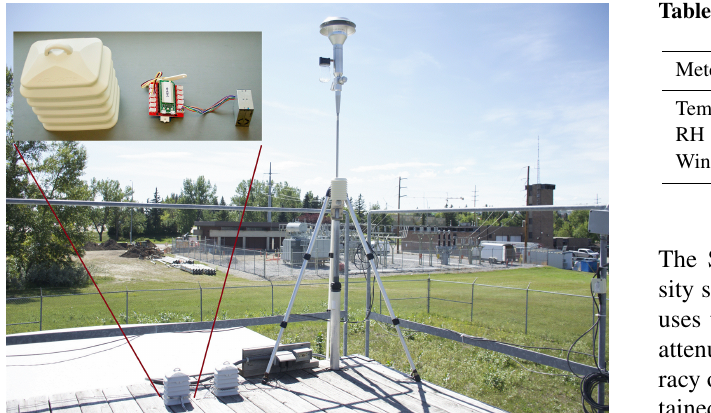
Figure 1. The low-cost sensor used in the study and the ambient inlet of the reference method – SHARP model 5030.